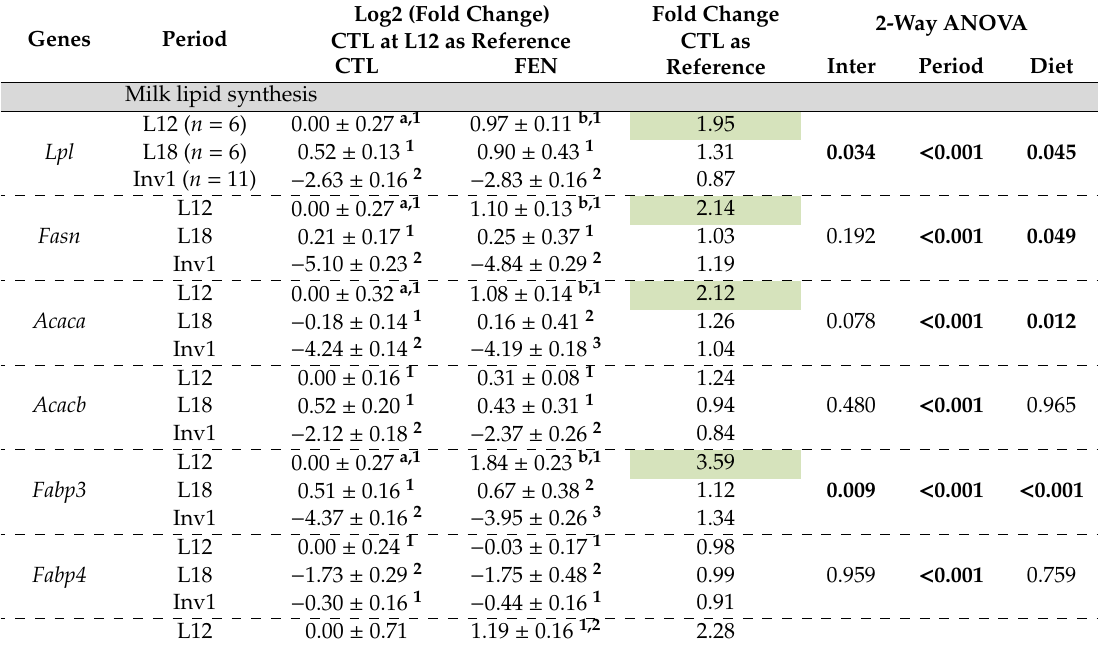
Table 2. E ff ect of fenugreek supplementation on relative expression of milk constituent synthesis genes in mammary gland along lactation